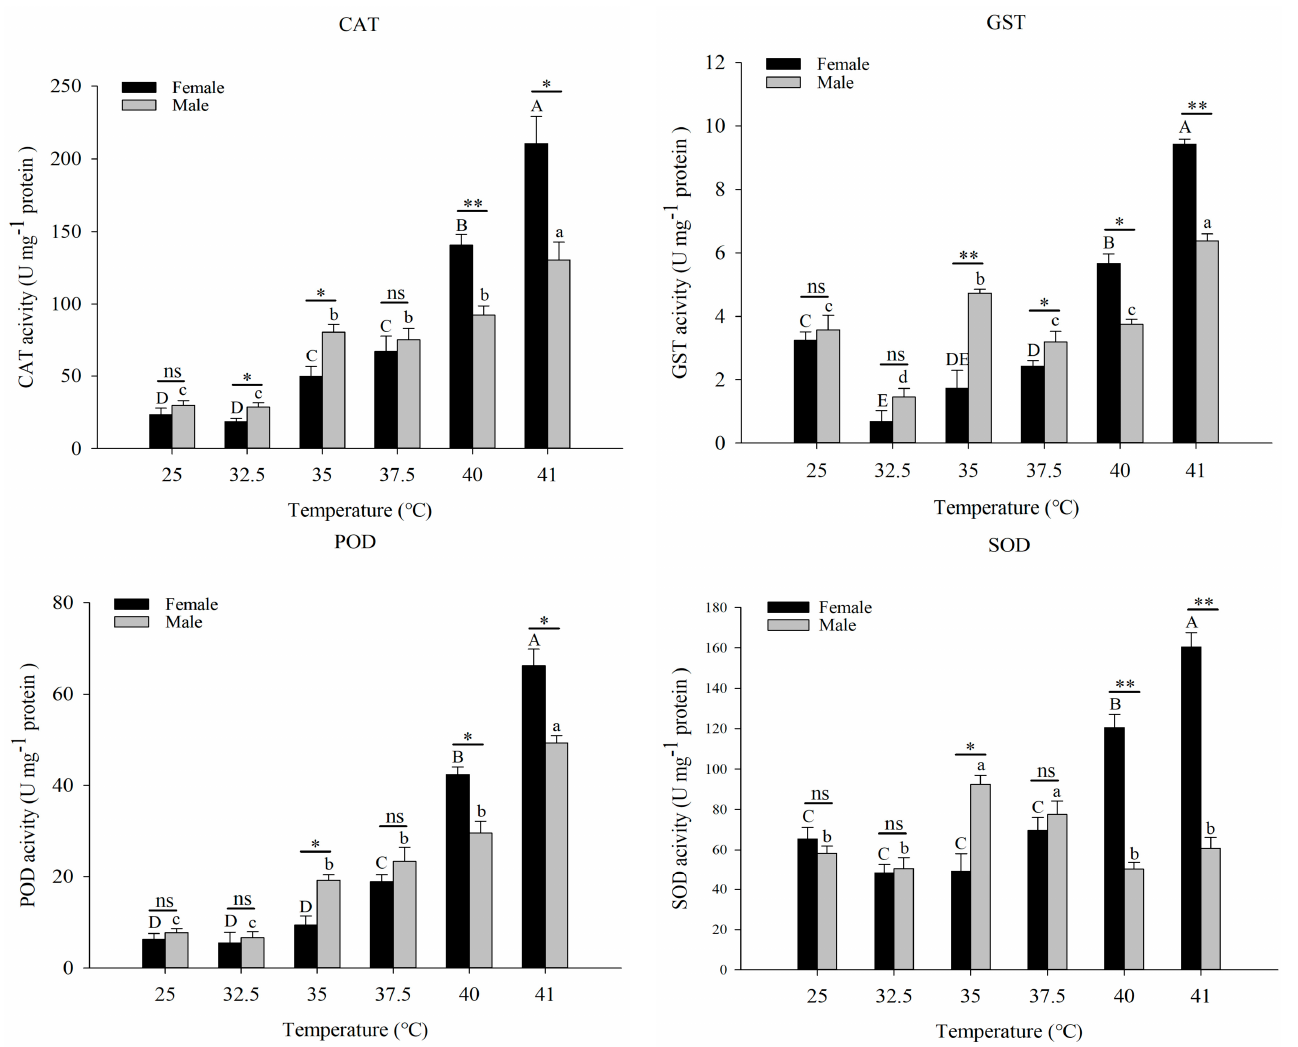
Figure 4. The effect of short-term heat treatment on the antioxidative enzyme activities of Aphelinus asychis . Each value represents the mean ( ± SE) of three replications. Uppercase and lowercase letters indicate significant differences between adult females and males treated at different temperatures ( p < 0.05). “*”, “**” mean significant differences between female and male adults at each temperature treatment, respectively ( p < 0.05 and p < 0.01); “ns” means no significant differences between two columns at each temperature treatment.